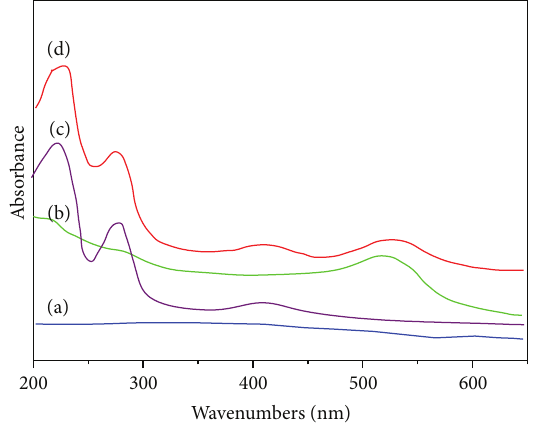
Figure 5: UV-Vis absorption spectrum of (a) Fe 3 O 4 @SiO 2 , (b) Fe 3 O 4 @SiO 2 @Au, (c) anti-CRP2/HRP, (d) Fe-Au MNPs-anti- CRP2/HRP conjugation. Table 1: Comparison of CRP levels in patient human serum samples ( 𝑛 = 3 ) determined using two methods. The developed method The classical ELIAS Serum samples